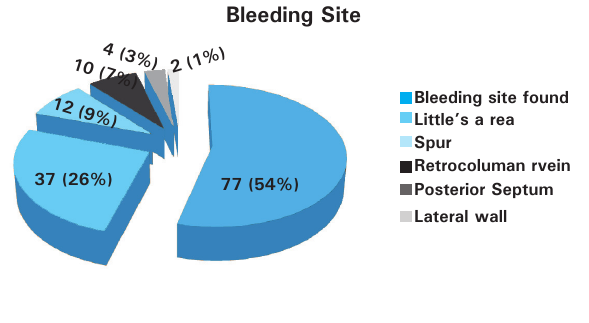
Figure 3. Different bleeding sites. Deviated nasal septum was seen in 112 (78.8%) patients. Out of 109 patients with unilateral bleeding, 65 (59.6%) patients had bleeding from convex